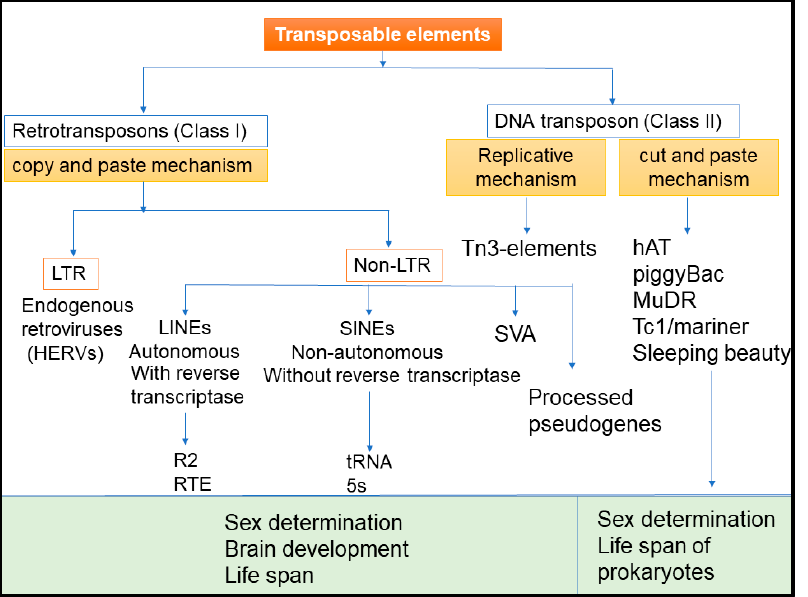
Figure 1. Classification of human transposons.